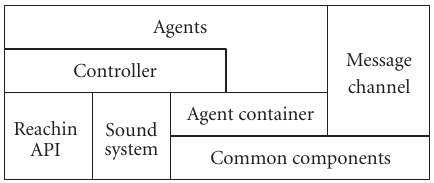
Figure 3: Layered view of the